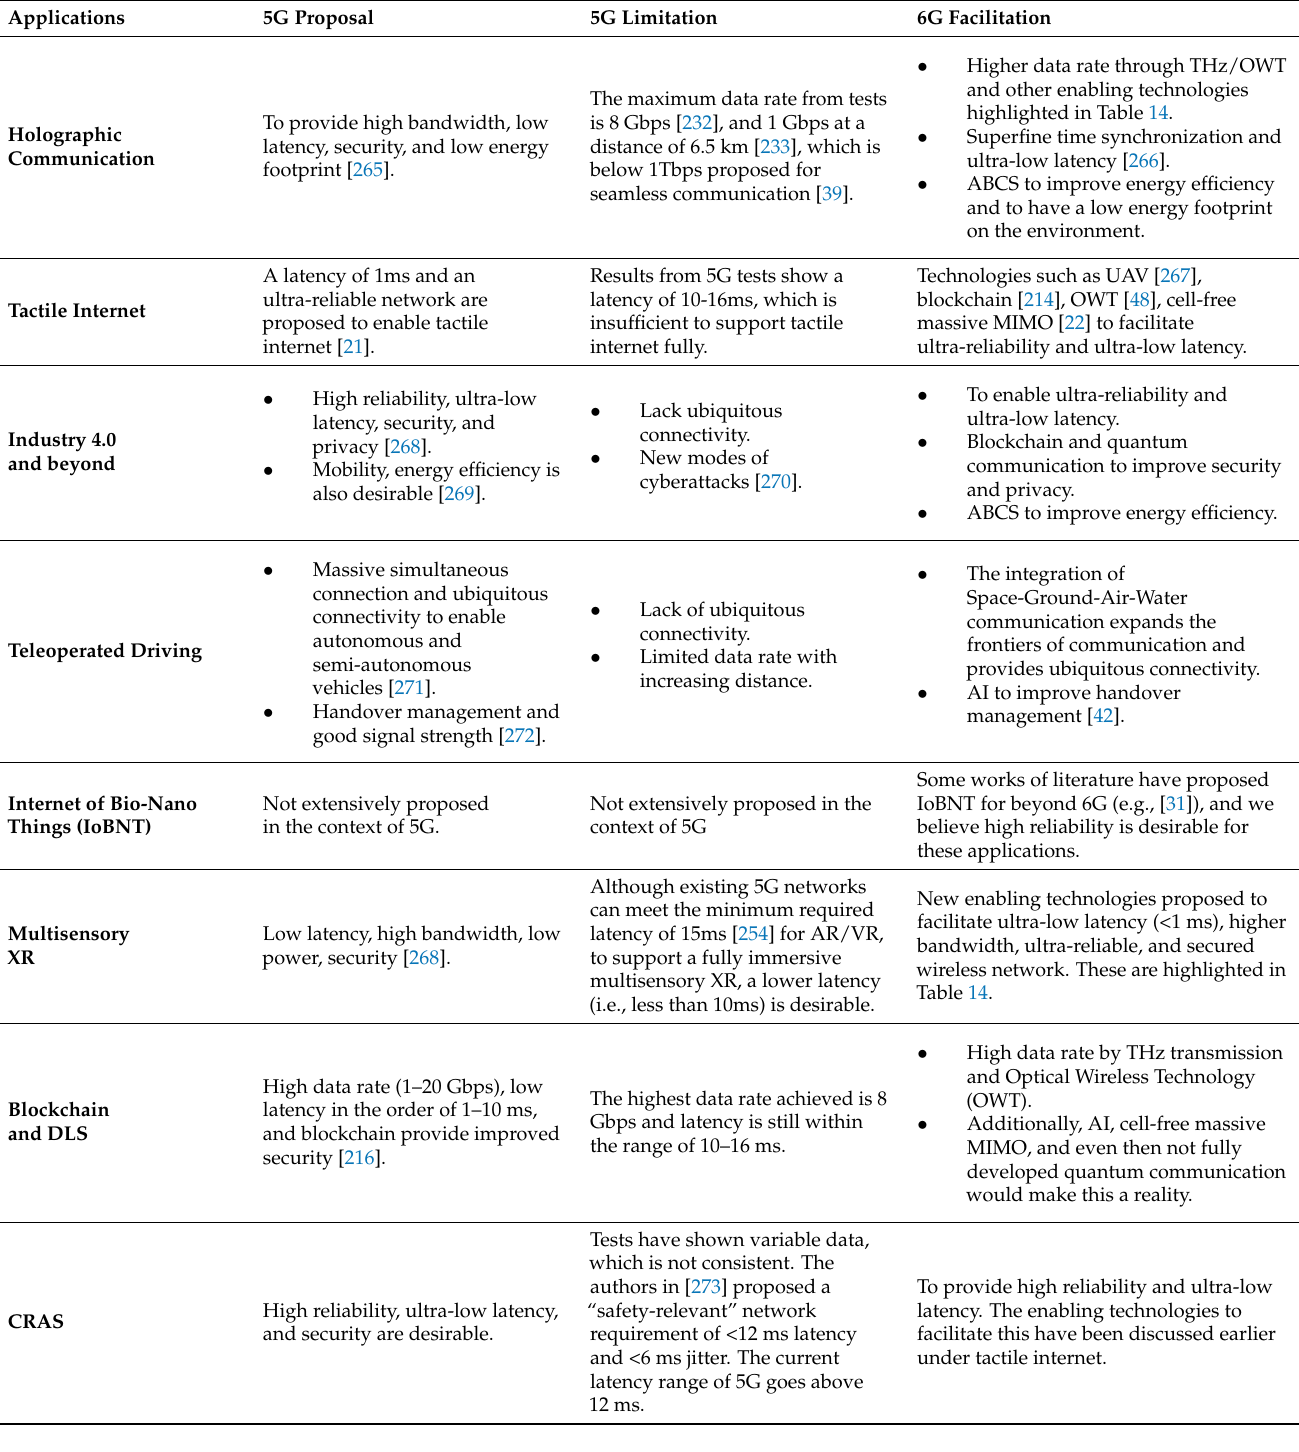
Table 17. Comparative analysis of the proposed applications in 5G and